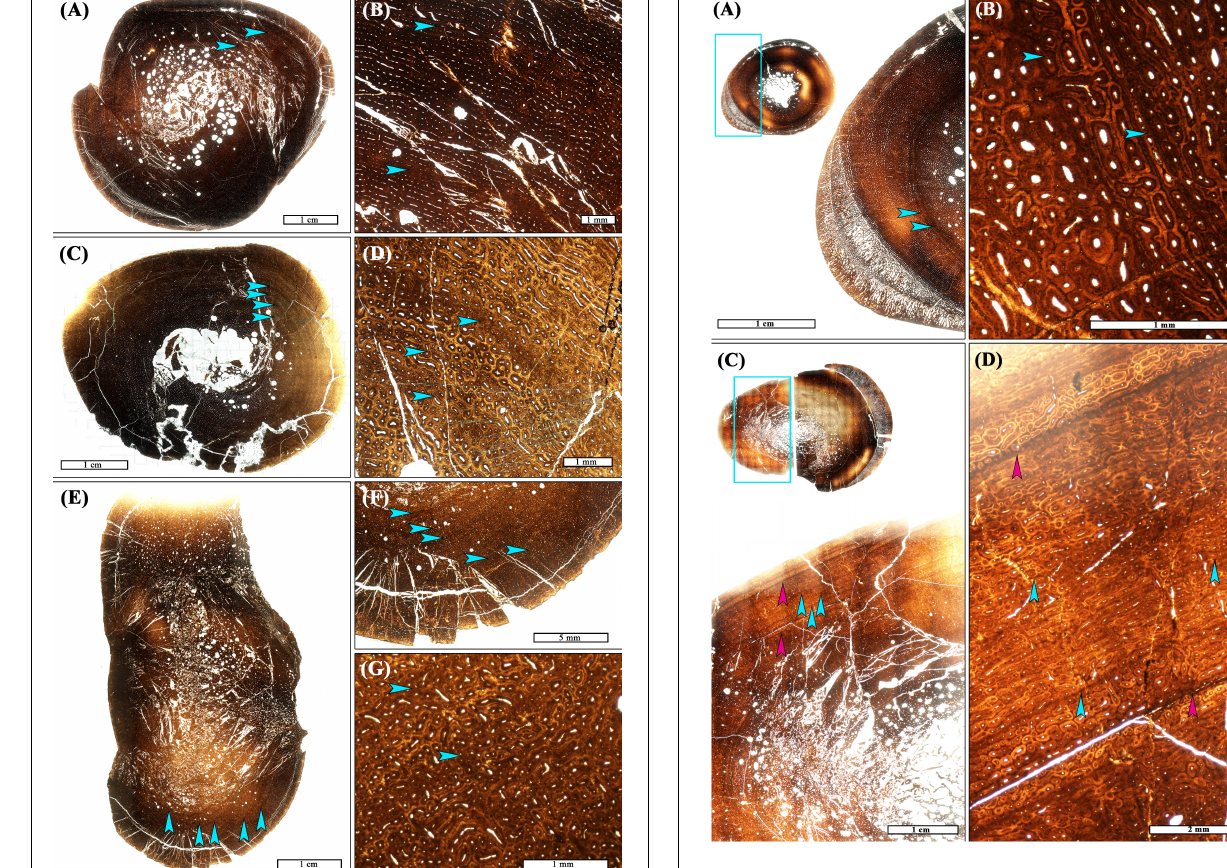
FIGURE 2 | Two Maiasaura tibiae from the fifty tibia dataset show histological evidence of pathology in the form of directional radial outgrowths in transverse section, and both possess LVCs. (A) Small tibia T09 (inset) does not have lines of arrested growth (LAGs), but there are two pronounced LVCs visible within the mid-cortex (arrows). The blue box on the inset image indicates the enlarged region in the panel. (B) Magnification of T09 shows the LVCs to be made of smaller laminar to longitudinal primary osteons compared to adjacent laminar and longitudinal primary osteons. (C) Subadult-size tibia T42 (inset) possesses at least four LAGs (two are shown with pink arrows) and LVCs are observed throughout the cortex (the three most evident are shown with blue arrows). The blue box on the inset image indicates the enlarged region in the panel. (D) Magnification of cortical region showing three LVCs (blue arrows) in a zone of growth bounded by LAGs (pink arrows). These LVCs are made of smaller reticular to longitudinal primary osteons compared to those of adjacent laminae. All images are shown in plane polarized